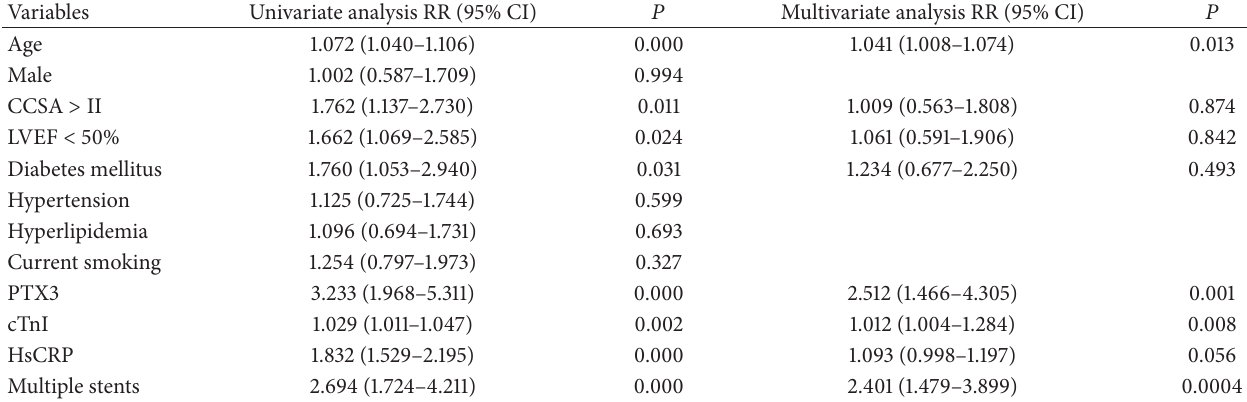
Table 4: Univariate and multivariate Cox regression analysis of major adverse cardiovascular